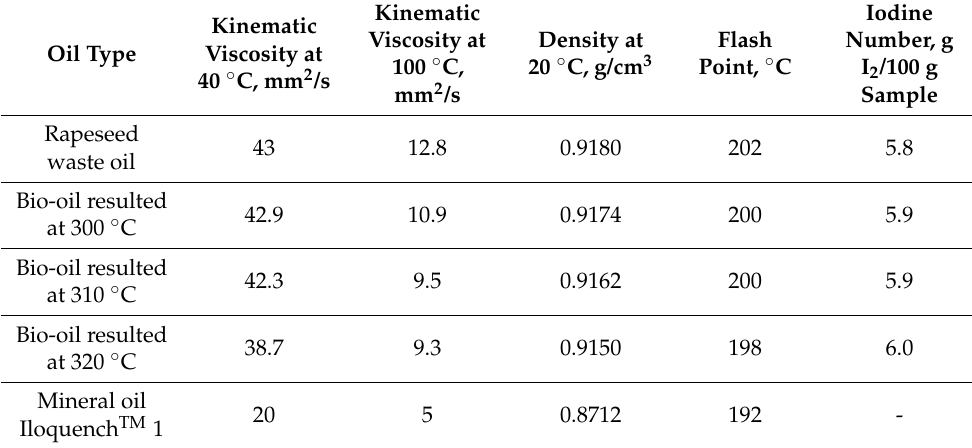
Table 3. Influence of pyrolysis temperature on the kinematic viscosity of bio-oils.